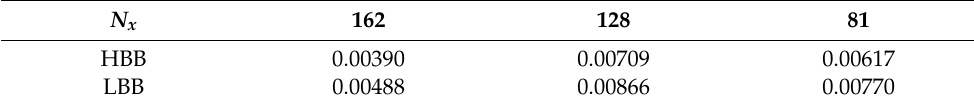
Table 6. Mean v t in aneurysm (normalized with U ). N x